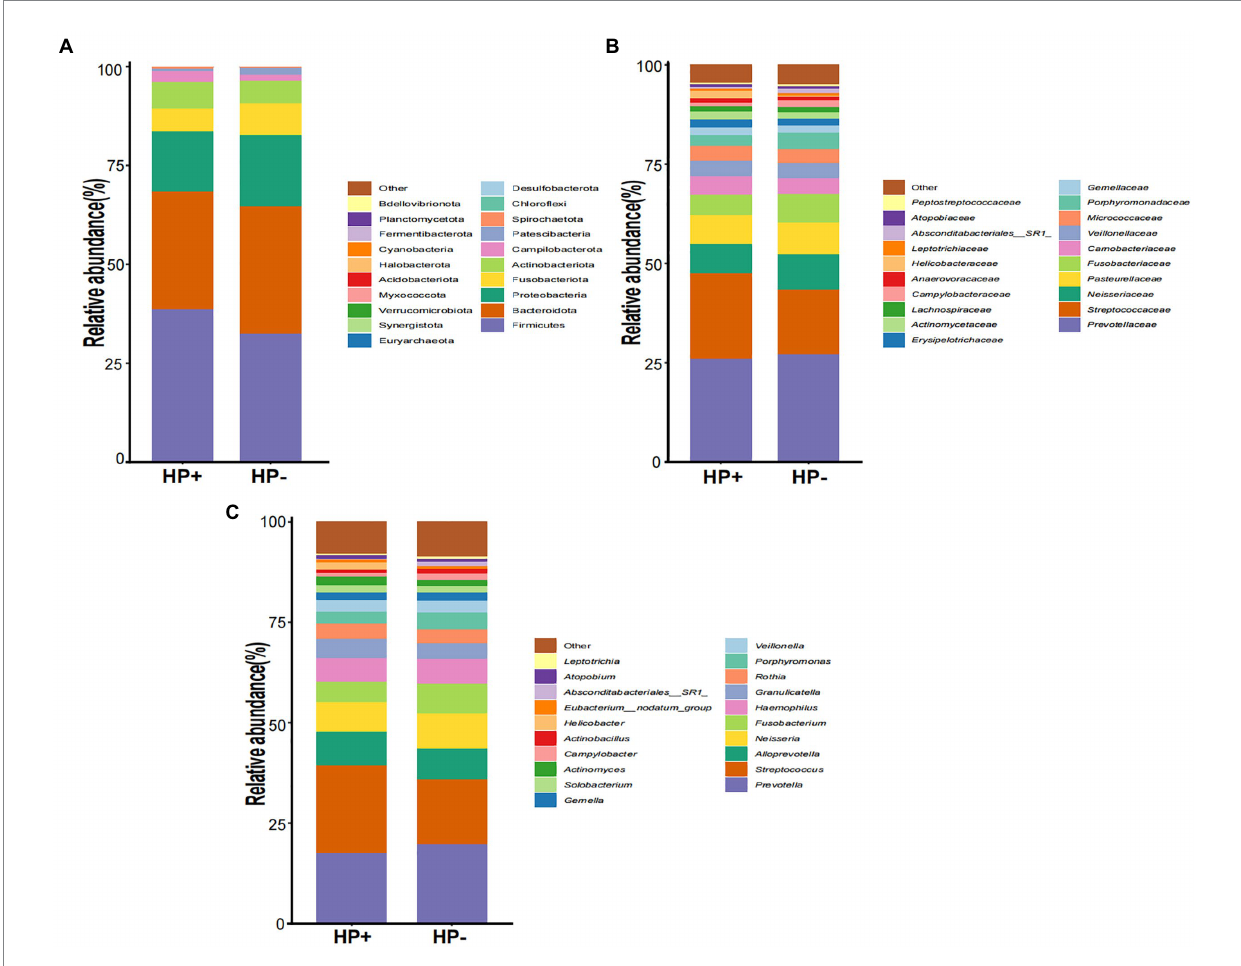
FIGURE 2 The microbial abundance of GJM in HP − and HP+ PCG. Microbial abundance is shown at the (A) phylum level, (B) family level, (C) and the genus level.